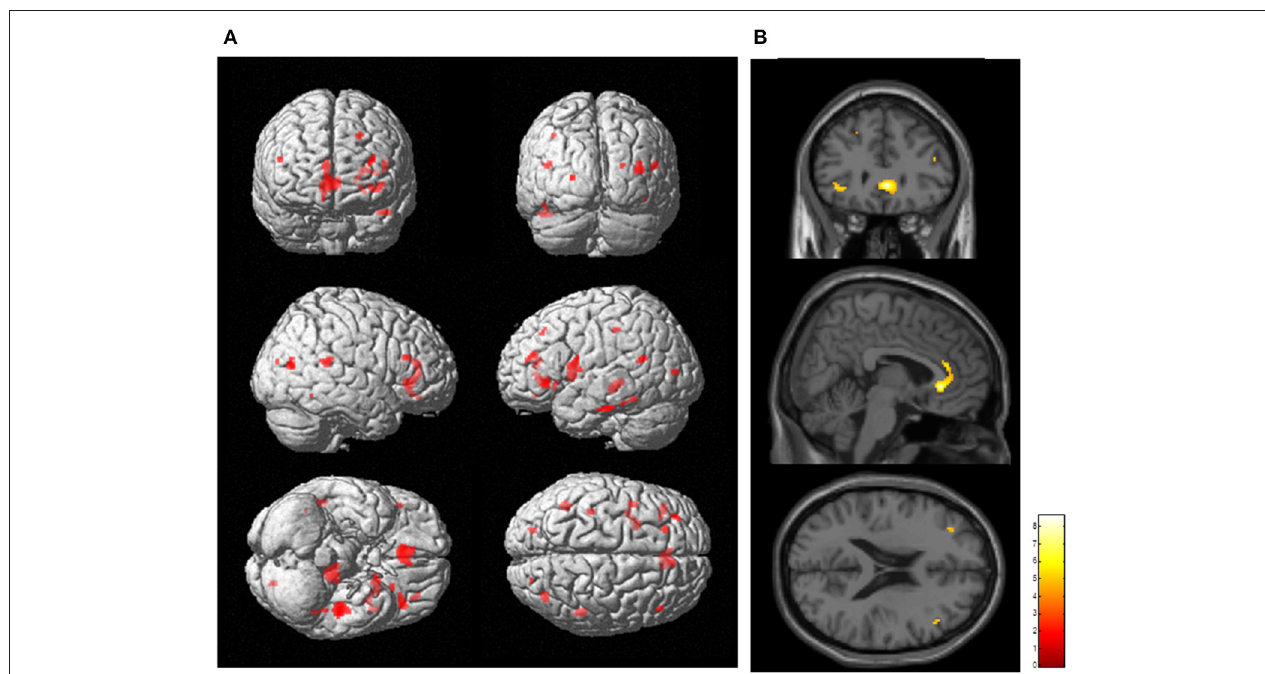
FIGURE 2 | Correlation analysis between regional [ 11 C]FMZ BP ND and frontal assessment battery (FAB) total scores in patients with Parkinson’s disease. The statistical threshold was set at P < 0.001, uncorrected multiple comparisons. (A) Results are shown on a three-dimensional rendering of the brain surface (shown in red). Color bar represents the T value. (B) The results are shown on canonical T1 images (shown in yellow). There was a significant positive correlation between the total FAB score and some frontal